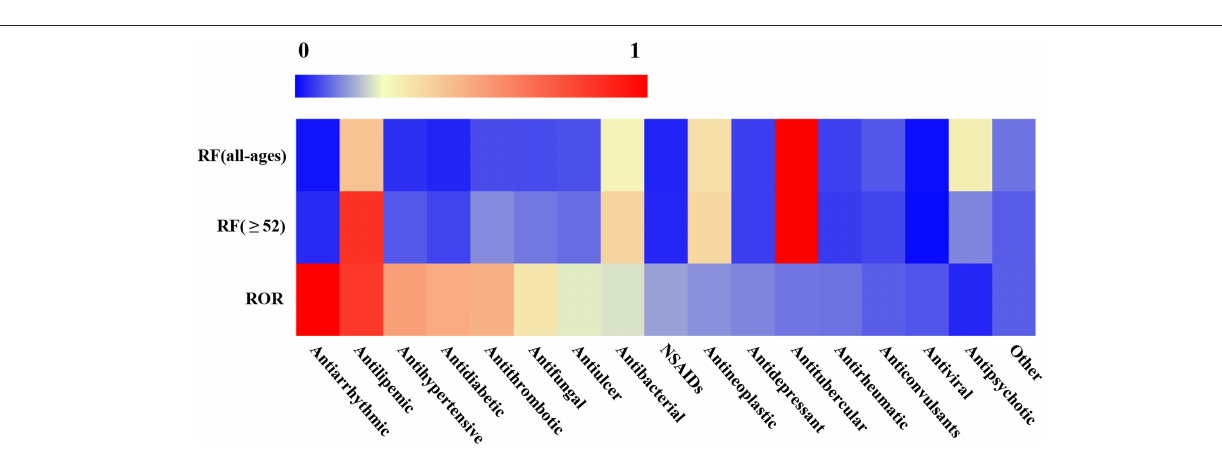
FIGURE 3 | Heatmap of RF and ROR of different drug categories. The values of reporting frequency (RF) and ROR were normalized within 0–1, respectively, to make the comparability. The drug categories were ranked from left to right according to their ROR values except for other